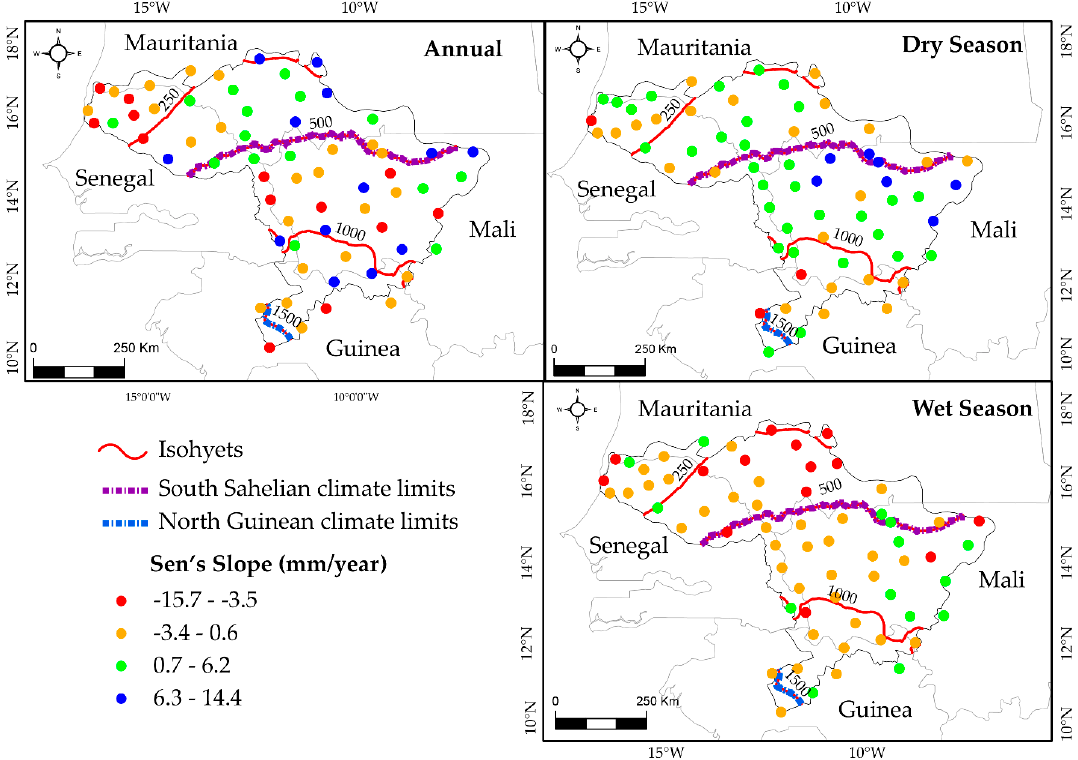
Figure 6. Spatial distribution of Sen’s slope of annual and seasonal evapotranspiration over 1984– 2017. Table 1. Summary of Sen’s slope average values ( β per year) for evapotranspiration and climatic variables: u2 wind speed, Tmax maximum temperature, Tmin minimum temperature, Rh relative humidity, Sr Solar radiation.